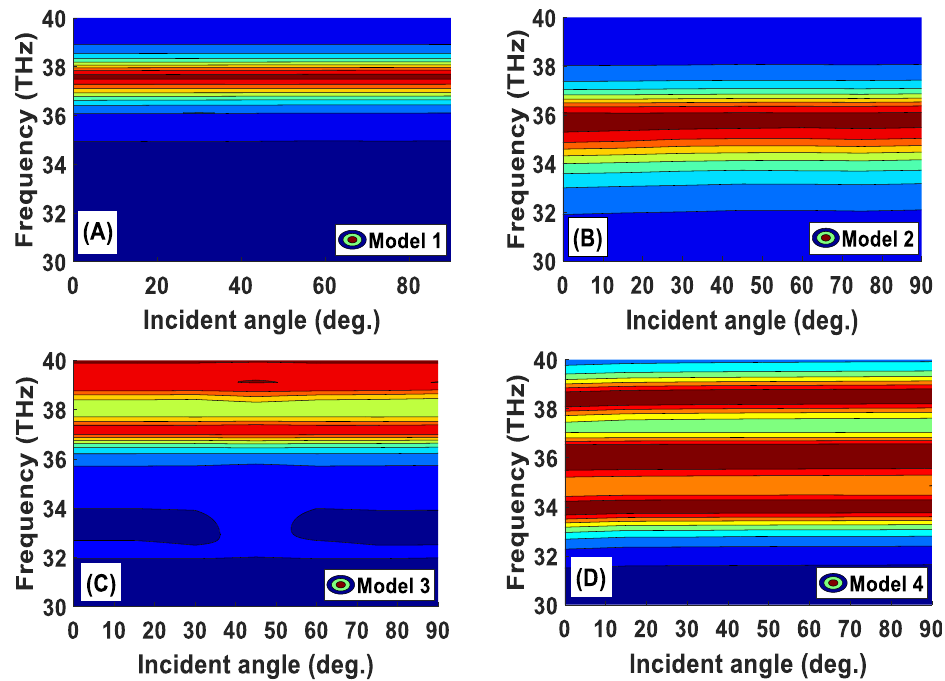
Figure 4. Color contour plot of frequency-dependent incident angle for different proposed models. The color bar on the right side of the figure shows the absorption value.